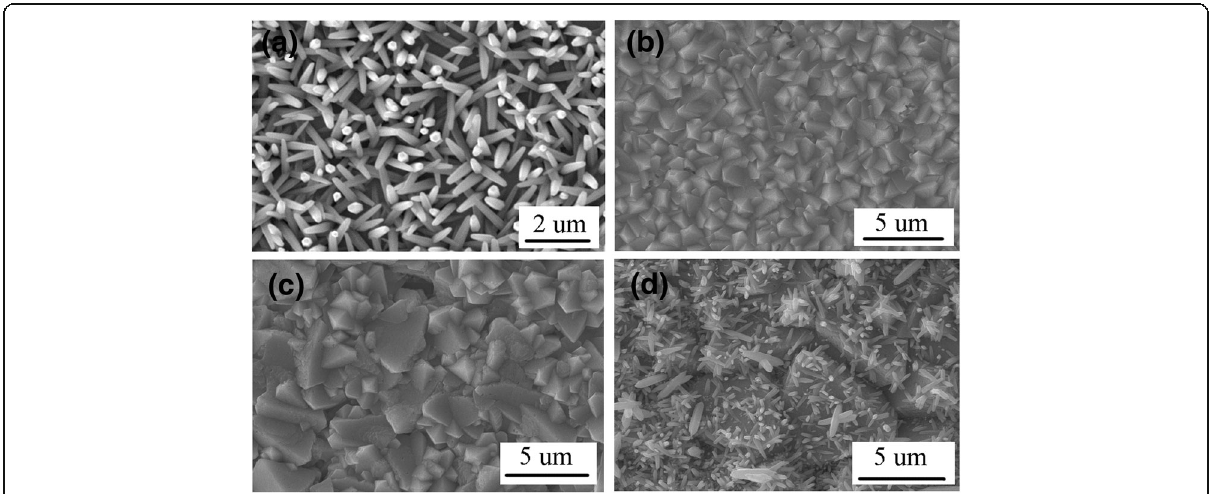
Fig. 2 The top view SEM image of ZnO nanorods ( a ), ZnO/Cu 2 O (pH 12, 20 min) heterojunction ( b ), Cu 2 O (pH 12, 20 min) ( c ), and Cu 2 O (pH 12, 20 min)/ZnO heterojunction ( d )